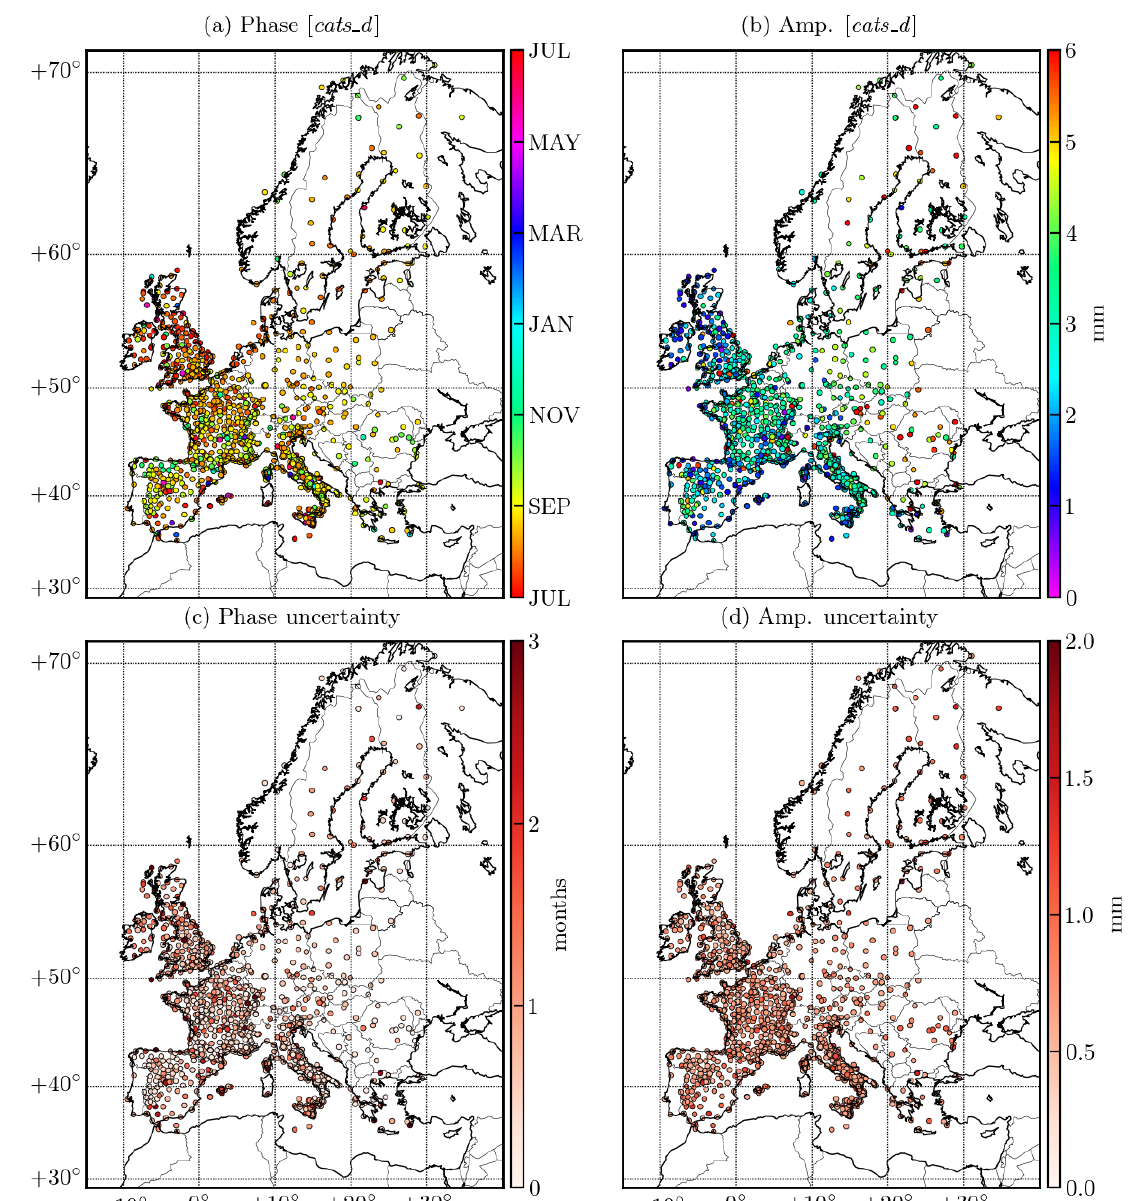
Figure 7. ( a ) Phase and ( b ) amplitude of cats_d along with their respective uncertainties ( c , d ) estimated using CATS software. The colour bar of the phase map indicates the month of maximum displacement towards the up